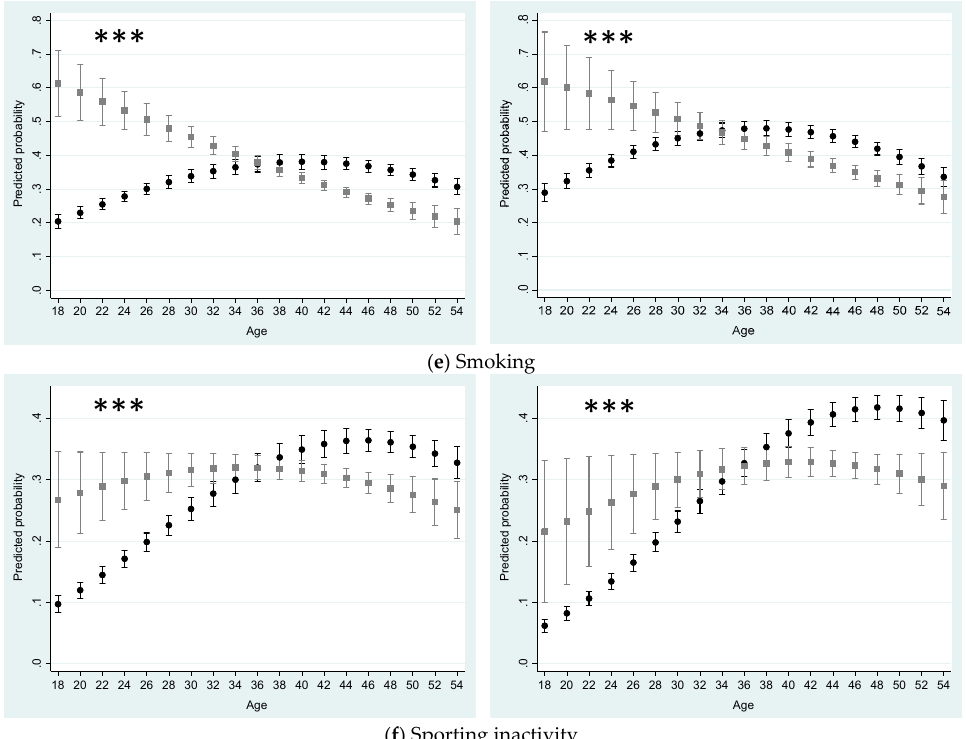
Figure 1. Health of women and men by parental status and age (in completed years) (predicted probabilities in %, 95% CI, adjusted for partner, socioeconomic and employment statuses, pre-school child in the household, region of residence). (cid:4) Child in the household; • No child in the household; Interaction between parental status and age: * p < 0.05; ** p < 0.01; *** p < 0.001; n.s.: not significant. For women, the interactions between age and parental status are highly significant for all health outcomes ( p < 0.001). Figure 1 shows that the association between parental status and health varies greatly with age. Young women (up to approx. 30 years of age) without children are healthier and behave healthier when comparing with women with children of the same age.